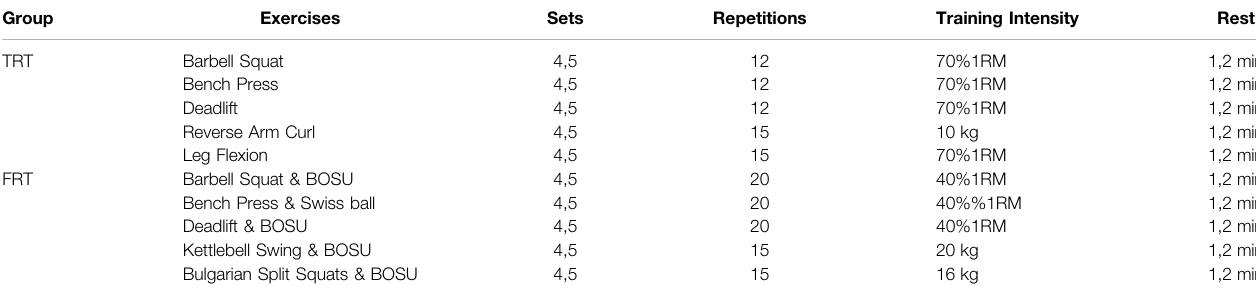
TABLE 1 | Resistance training protocols. Group Exercises